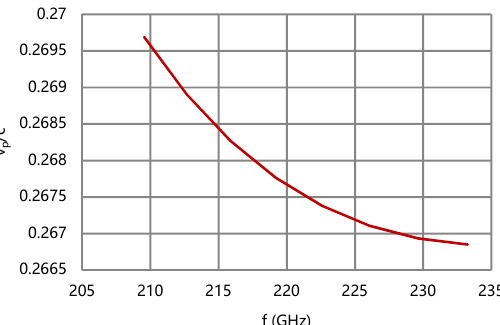
Figure 8. Coupling impedance of the folded waveguide circuit.